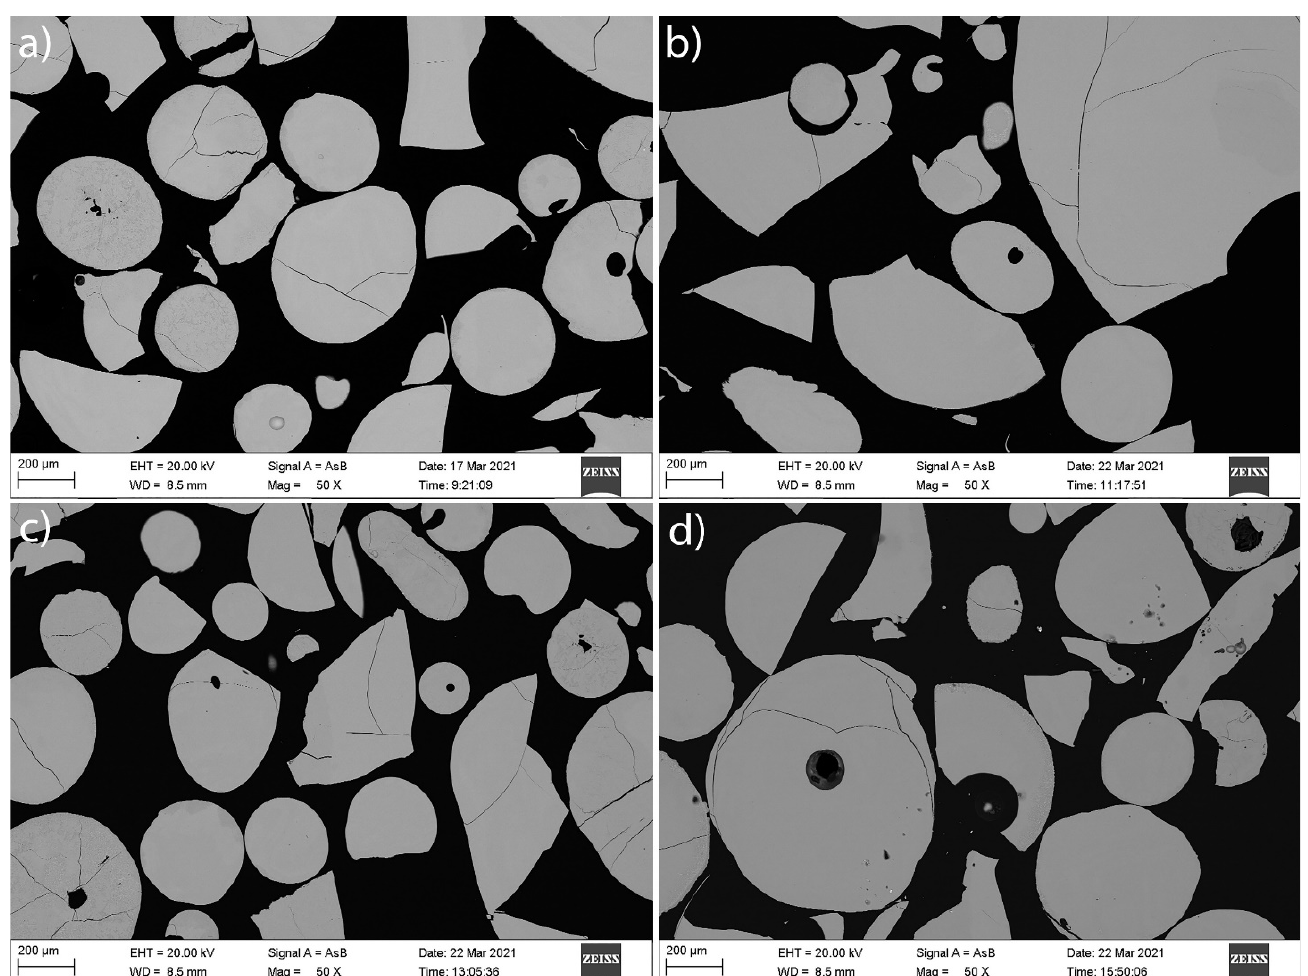
Figure 1. SEM–BSE images of granulated samples: ( a ) ZFS13-01; ( b ) ZFS13-10; ( c ) ZFS14-01; ( d ) ZFS14-10.